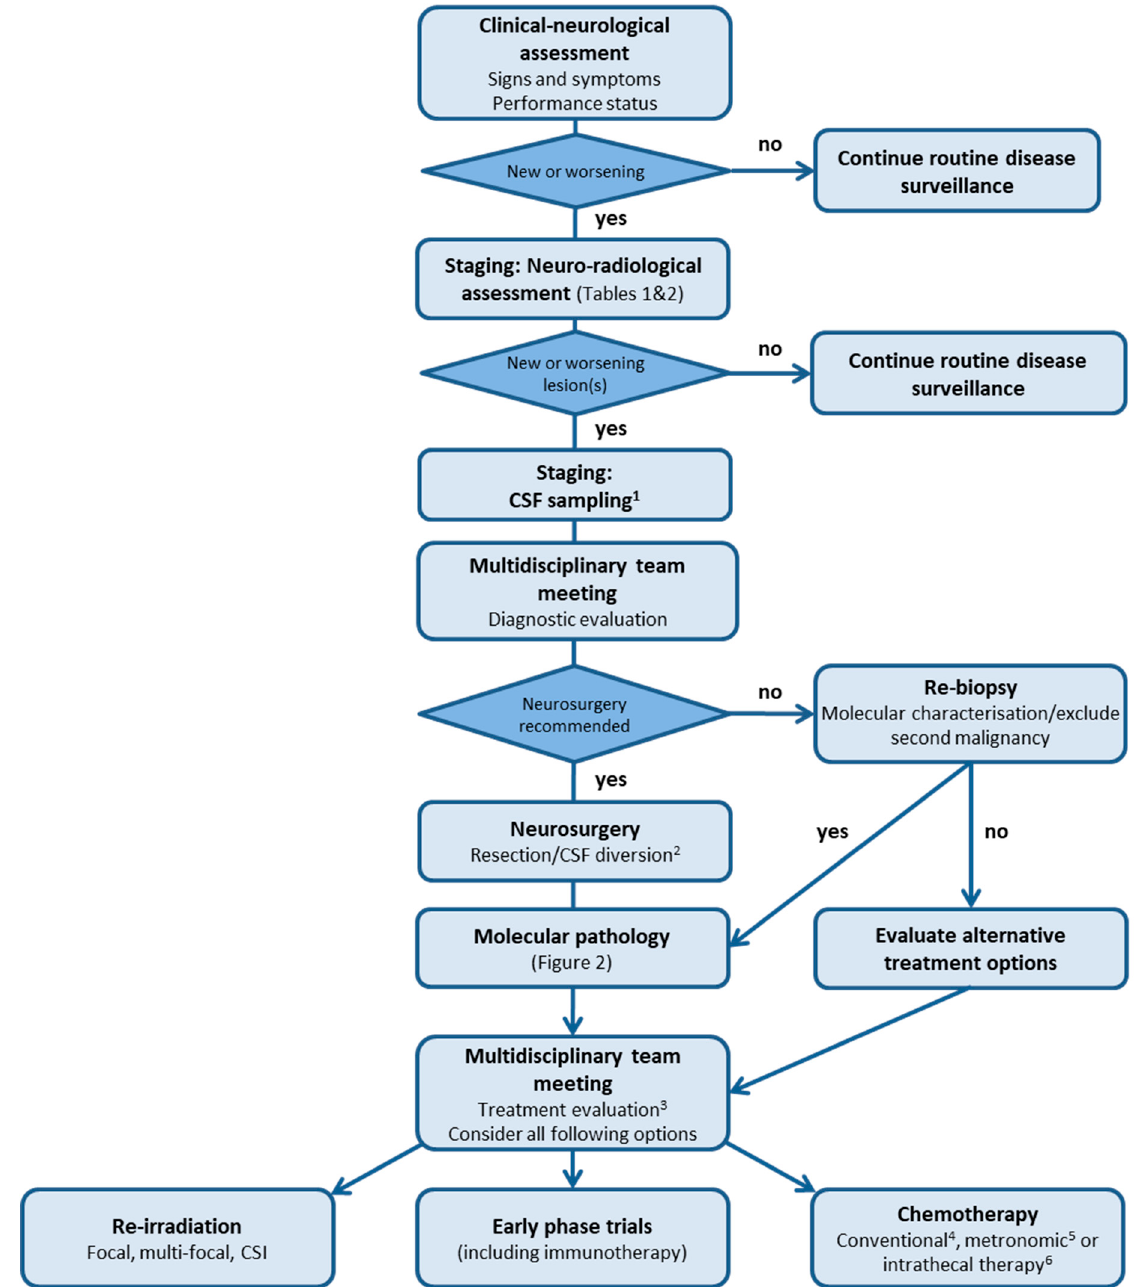
Figure 1. Flowsheet representing the clinical diagnostic process and treatment options for relapsed medulloblastoma. 1 Lumbar CSF if no clinical contraindication and additionally ventricular CSF if